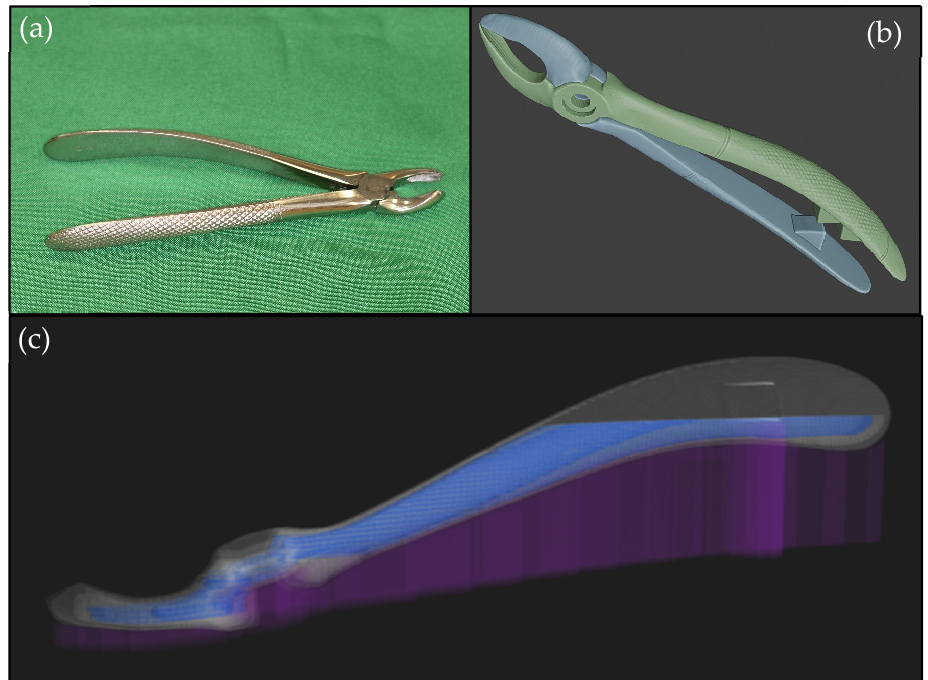
Figure 3. The mains steps of reverse engineering and 3D design of the forceps: ( a ) the original metal dental extractor; ( b ) the modified model in .stl format; ( c ) the sliced model ready for printing .